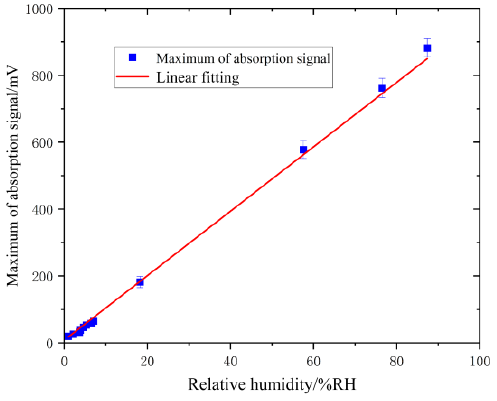
Figure 7. Relative humidity measured in DAS-TDLAS.